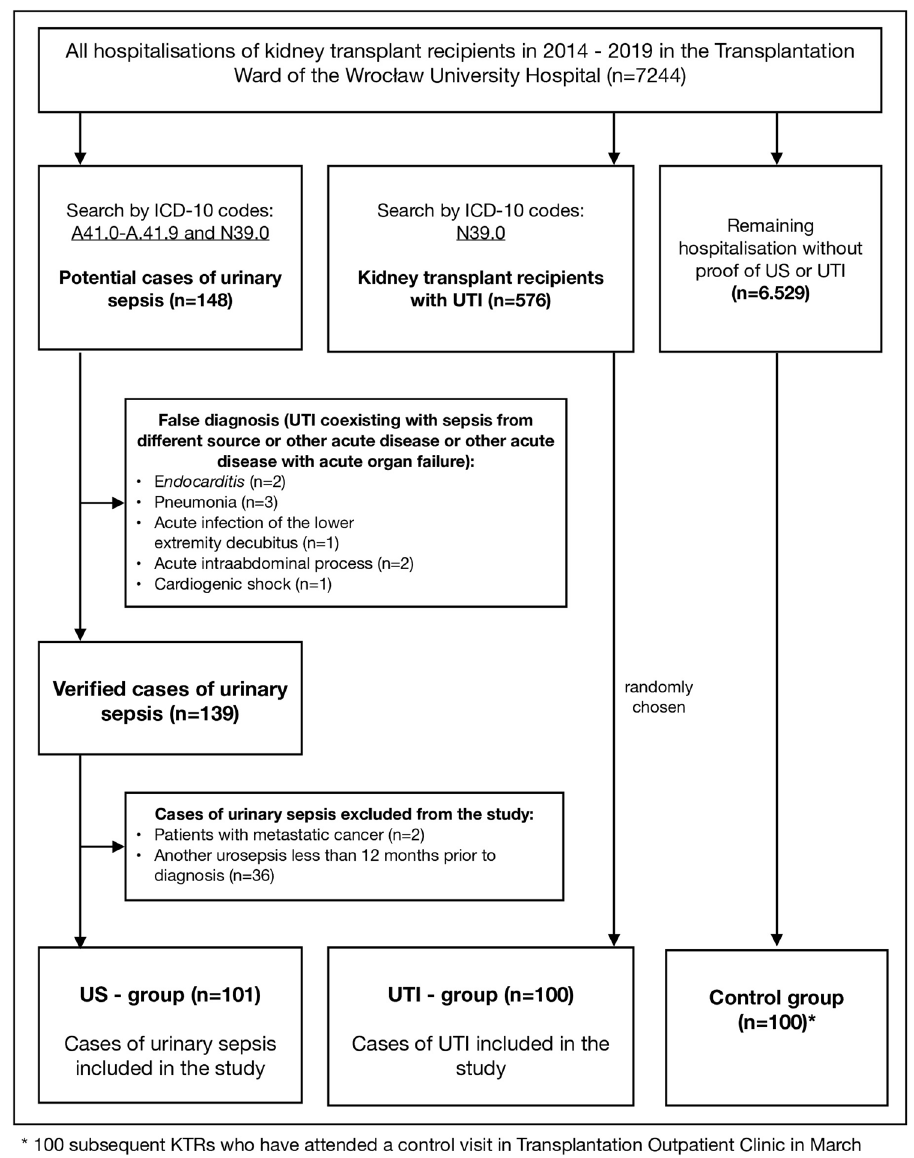
Figure 1. The selection process of patients into the study